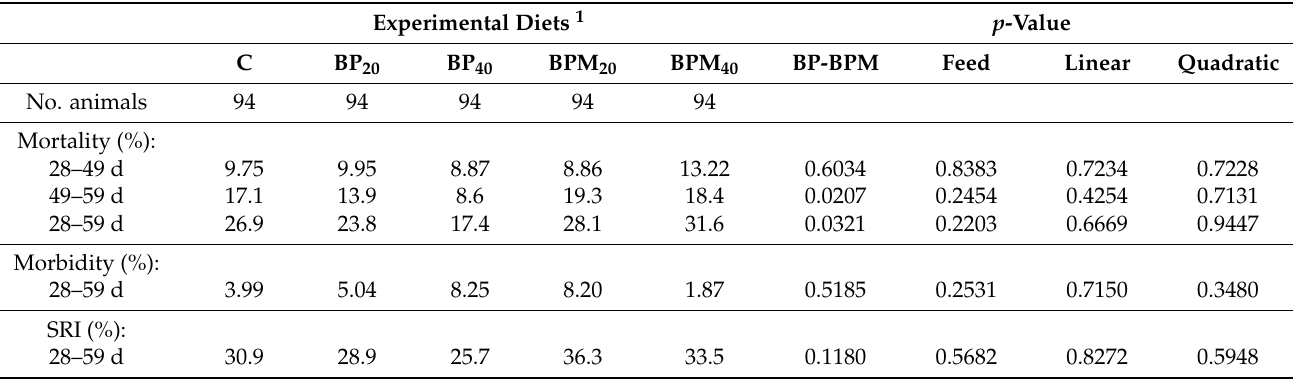
Table 2. Effect of beet pulp inclusion (with or without molasses) on the mortality and morbidity of fattening